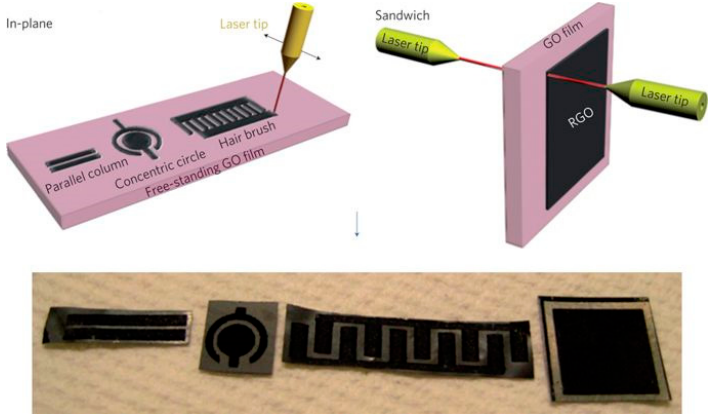
Figure 5. Schematics of laser patterning of free-standing hydrated GO films for fabrication graphene micro-supercapacitor devices with in-plane and sandwich geometries. Reprinted with permission from Reference [106]. Copyright © 2011 Nature Publishing Group.